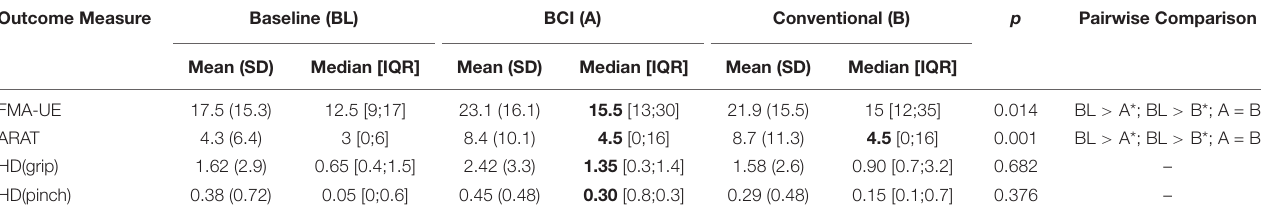
TABLE 2 | Clinical and hand dynamometry (kgf) outcomes. Outcome Measure Conventional (B) p Pairwise